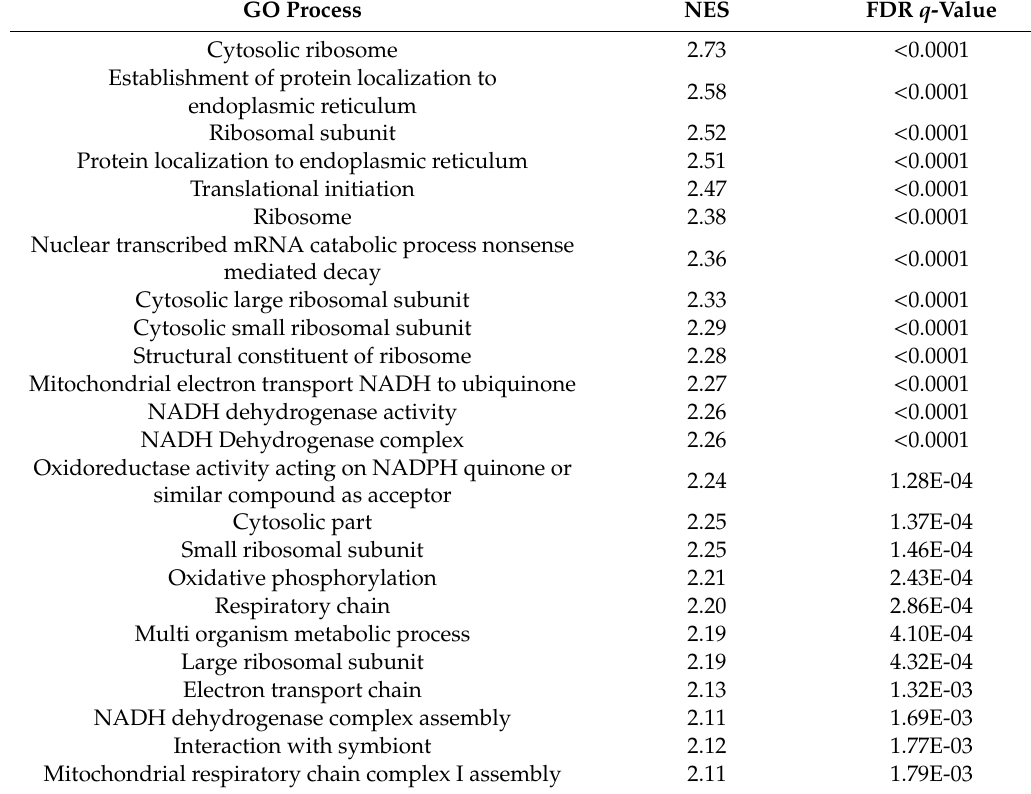
Table 1. Biological processes enriched through